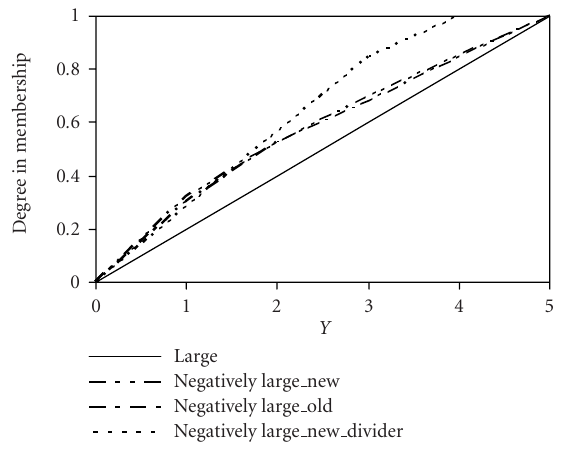
Figure 3.7. Schematic illustration of linguistic hedge “negatively.”